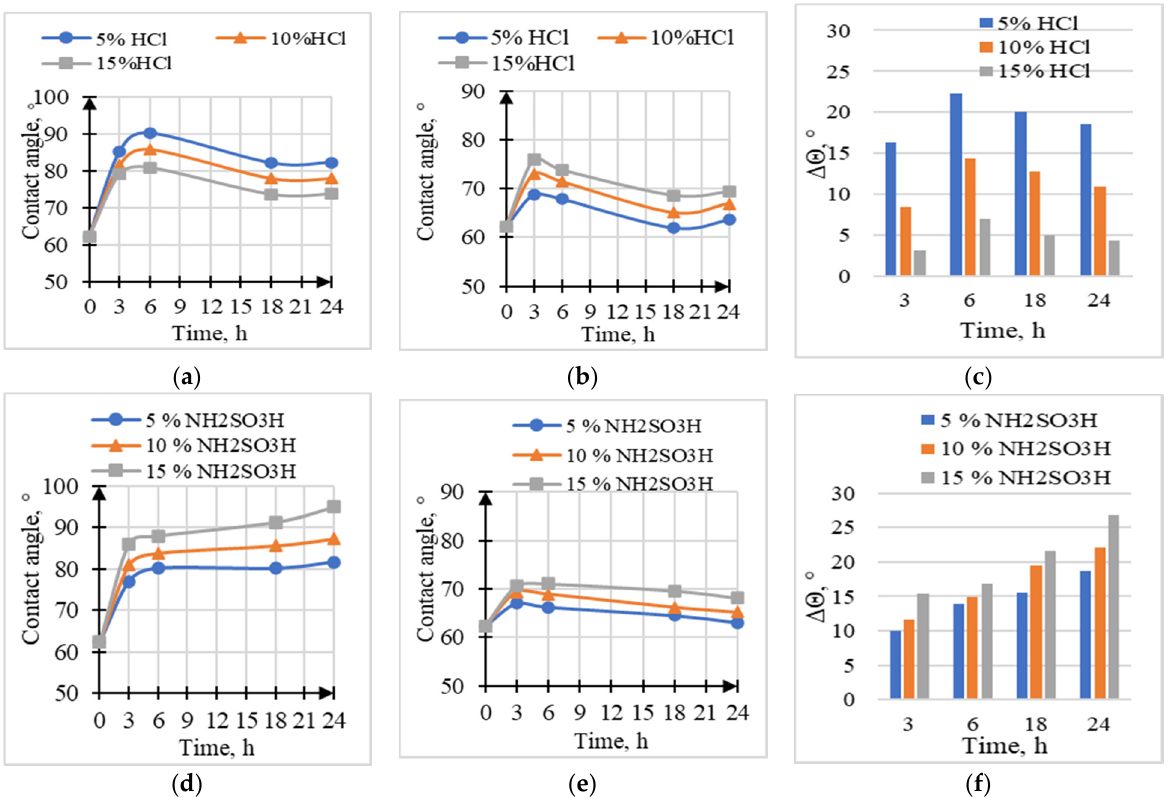
Figure 10. The contact angle of steel plates after corrosion at 3, 6, 18, 24 h in hydrochloric acid with the addition of the IC-1 inhibitor ( a ), without the addition of the inhibitor ( b ), and the difference in the contact angles adding IC-1 and without adding inhibitor ( c ), in sulfamic acid with the addition of the IC-2 inhibitor ( d ), without adding of the inhibitor ( e ), and the difference in contact angles with adding IC-2 and without the addition of the inhibitor ( f ).